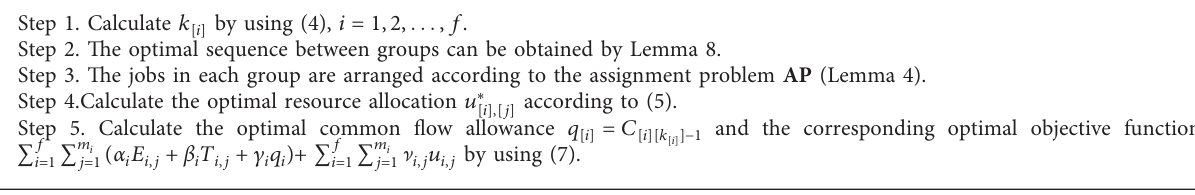
A LGORITHM 2: Optimal solution for Case